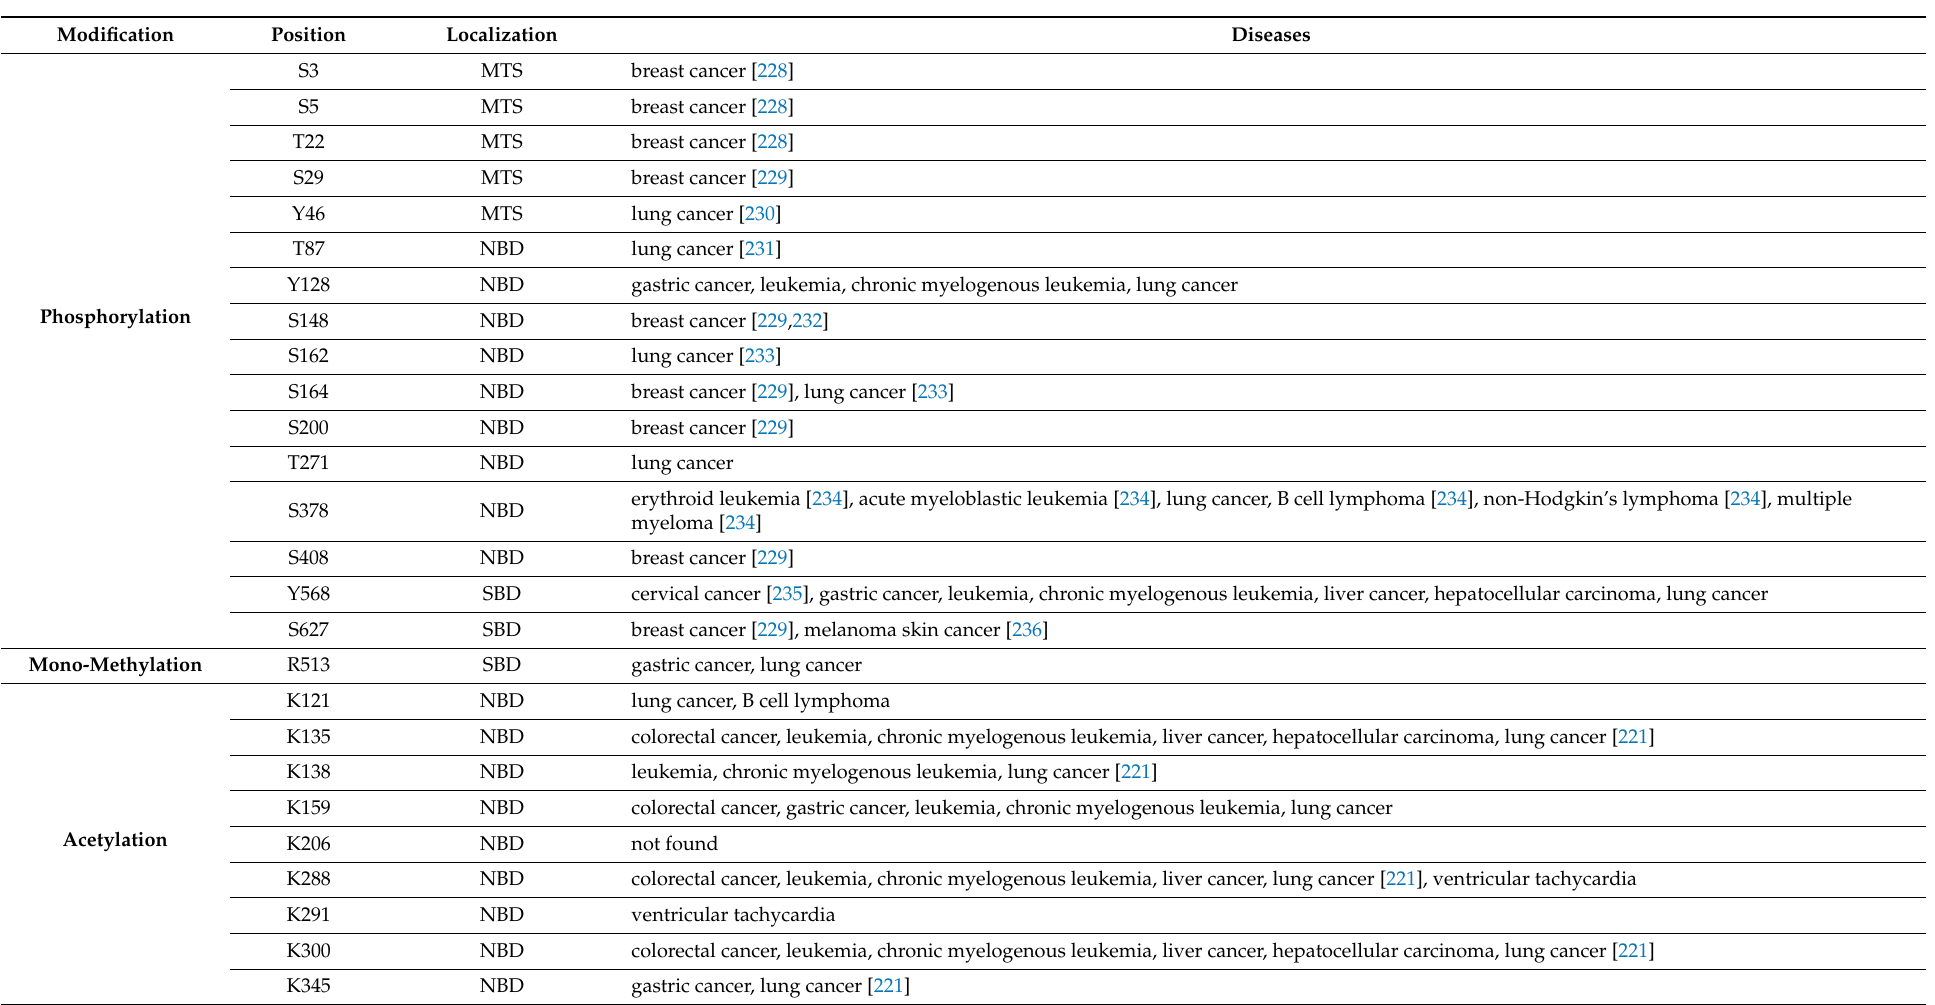
Table 1. The overview of mortalin post-translational modifications and their involvement in human diseases, which appear in the PhosphositePlus ® Database. Only modifications identified by at least five separate proteomic studies are listed below. A more detailed information about mortalin’s PTMs is included in Supplementary Table